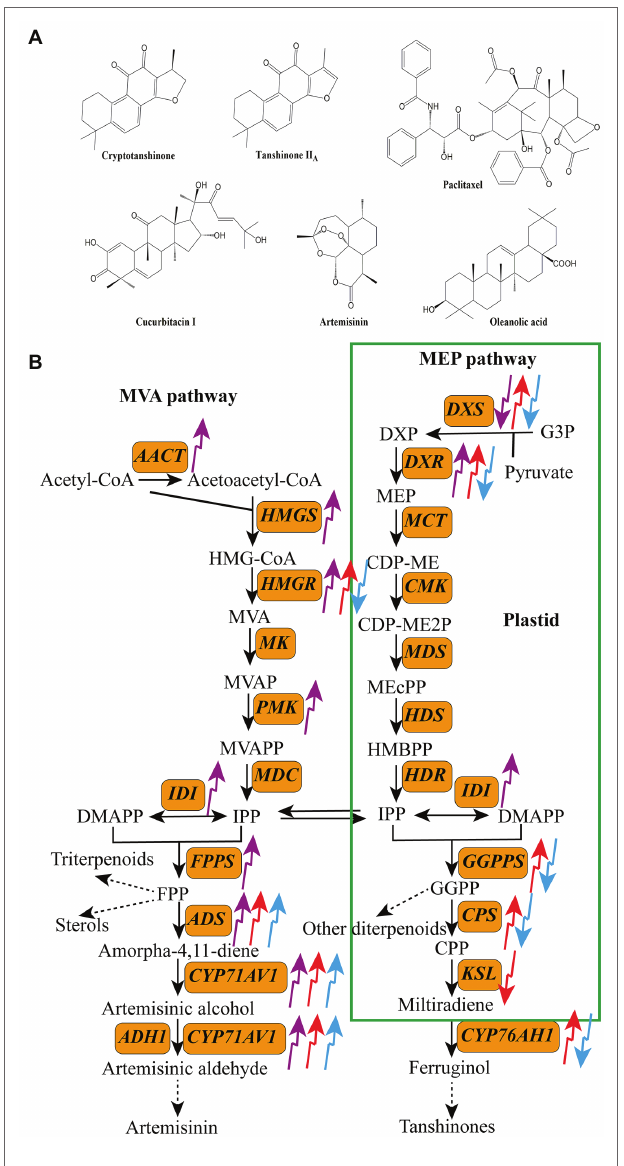
FIGURE 2 | Structures of some bioactive terpenoids in medicinal plants (A) and the effects of light quality on the transcripts of key enzyme genes in the biosynthetic pathways of terpenoids (B) . The upward arrows indicate upregulation and the downward arrows indicate downregulation. The purple arrow, red arrow, and blue arrow indicate UV-B, red light, and blue light, respectively. AACT , acetyl-CoA acyltransferase; ADH1 , alcohol dehydrogenase 1; ADS , amorpha-4,11-diene synthase; CMK , 4-diphosphocytidyl-2C-methyl-D-erythritol kinase; CPS , copalyl diphosphate synthase; CYP71AV1 , cytochrome P450 71AV1; CYP76AH1 , miltiradiene oxidase; DXR , 1-deoxy-D-lxylulose-5-phosphate reductoisomerase; DXS , 1-deoxy-D-xylulose-5-phosphate synthase; FPPS , farnesyl diphosphate synthase; GGPPS , geranylgeranyl diphosphate synthase; HDR , hydroxy-2- methyl-2-(E)-butenyl 4-diphosphate reductase; HDS , hydroxymethylbutenyl diphosphate synthase; HMGR , 3-hydroxy-3-methylglutaryl CoA